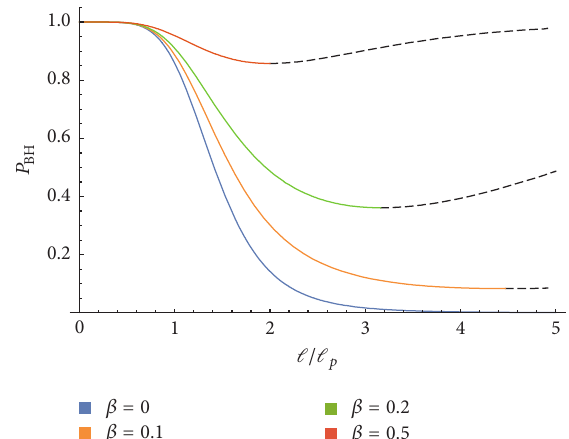
Figure 5: Analytic approximation of the probability 𝑃 BH (𝑚) for a particle to be a black hole versus Gaussian width for increasing values of thefree parameter 𝛽 . Dashed lines correspond to the values ℓ > √2/𝛽ℓ 𝑝 .